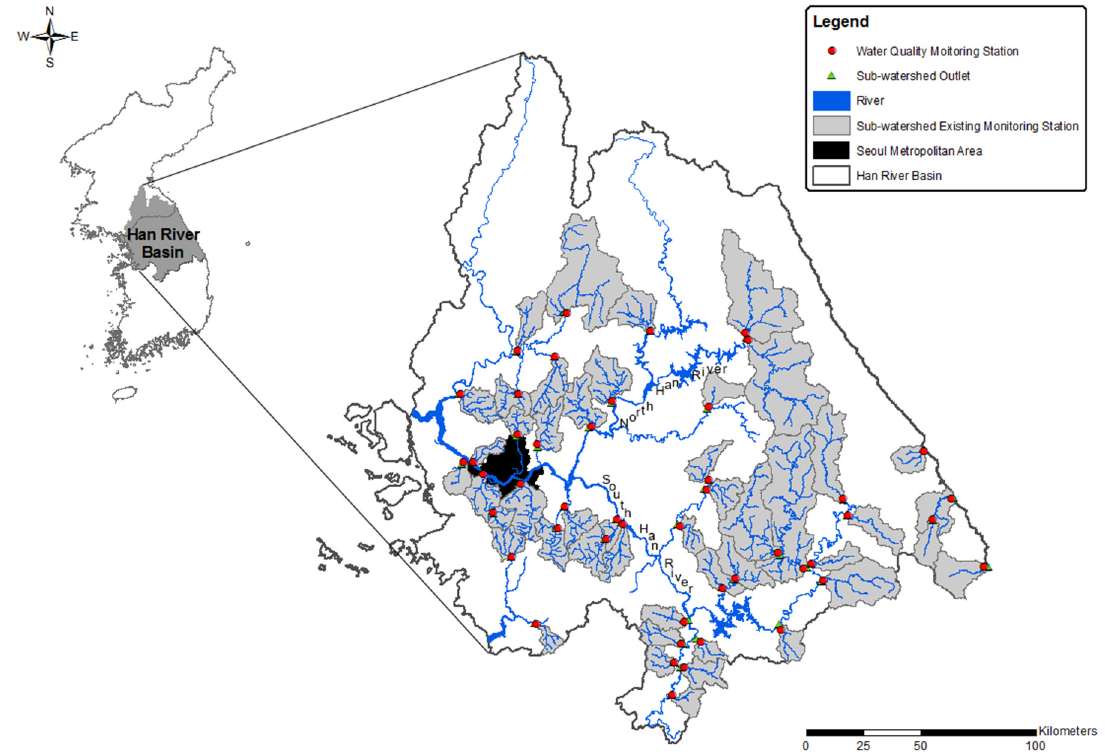
Figure 1. Location of the Han River Basin and water quality monitoring stations.